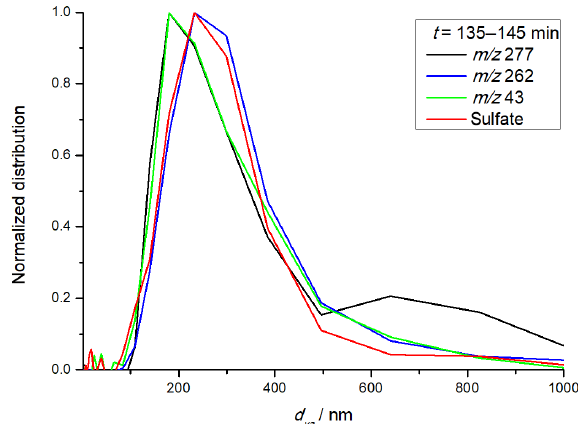
Figure 5. Size distribution of individual particle-phase compounds (TPPO, TPP, SOA, sulfate) within the first 10min after the addition of